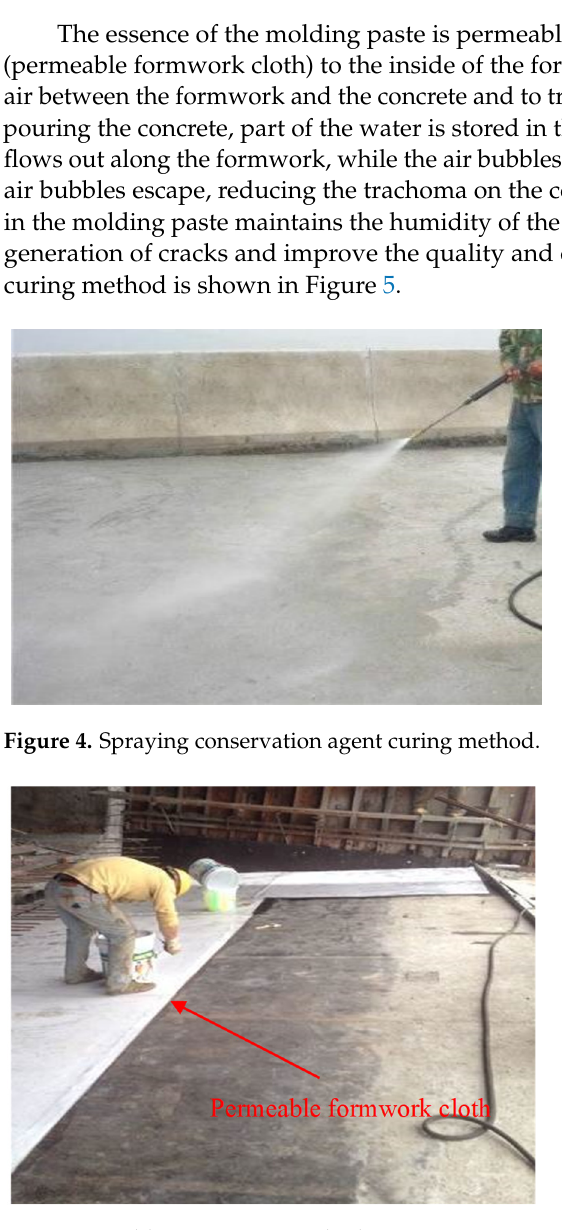
Figure 5. Mold paste curing method.